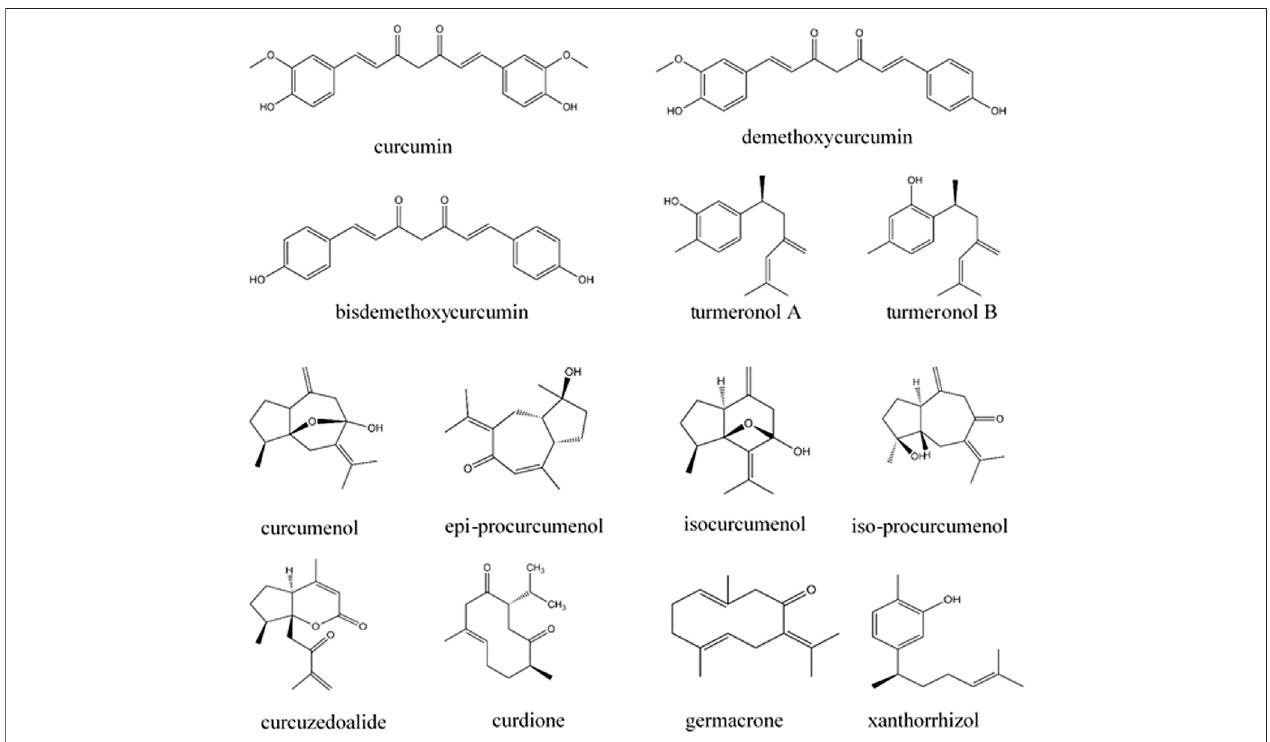
FIGURE 2 | Chemical structures of potential immunomodulators from Curcuma